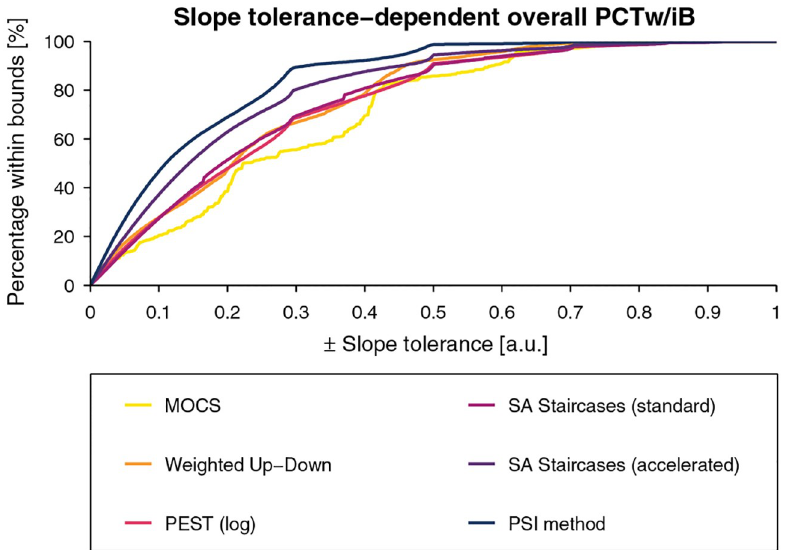
Fig 13. Overall percentage within bounds for the slope estimates. Overall percentage within bounds ( PCTw/iB ) function for slope estimation for a linearly resampled parameter space.